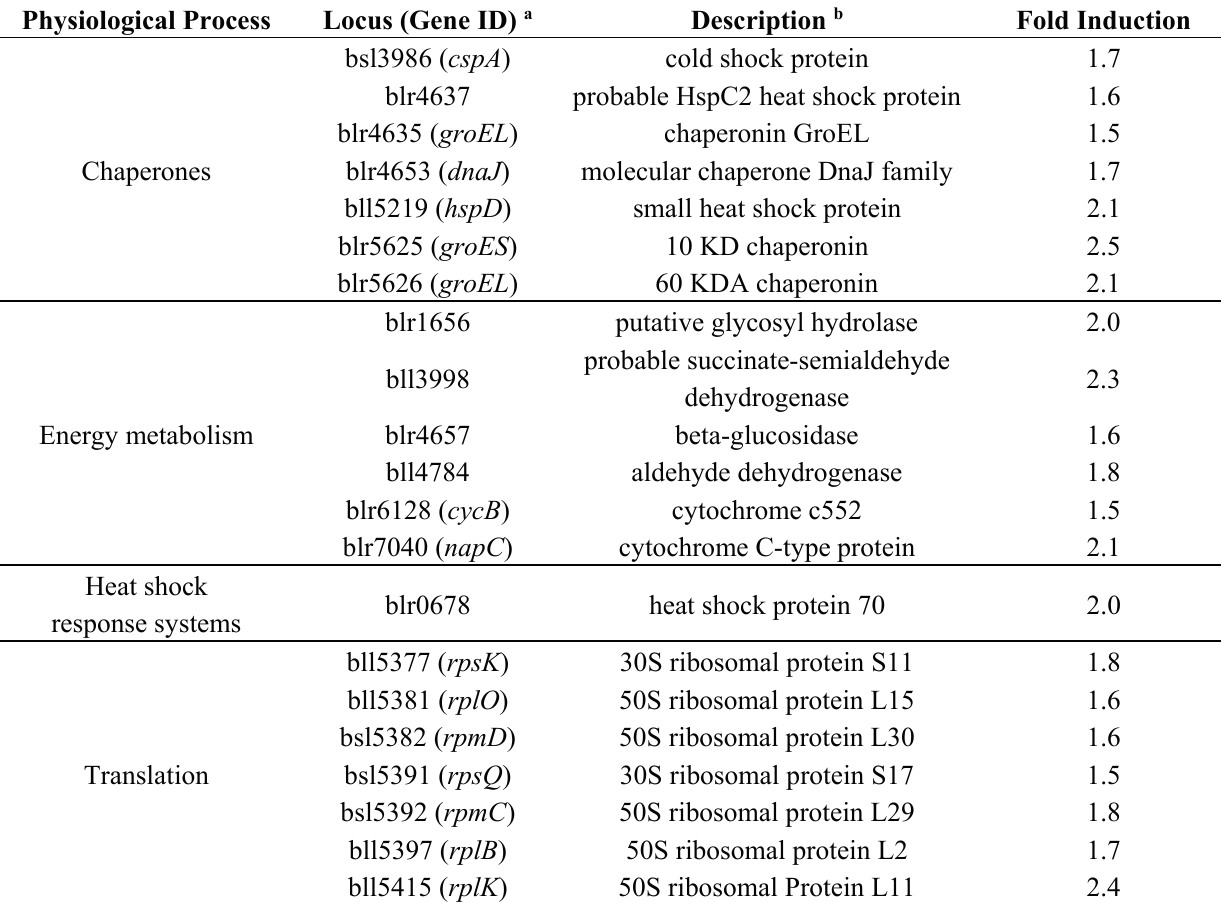
Table 3. Changes in expression of physiological process genes in desiccation-grown B. japonicum